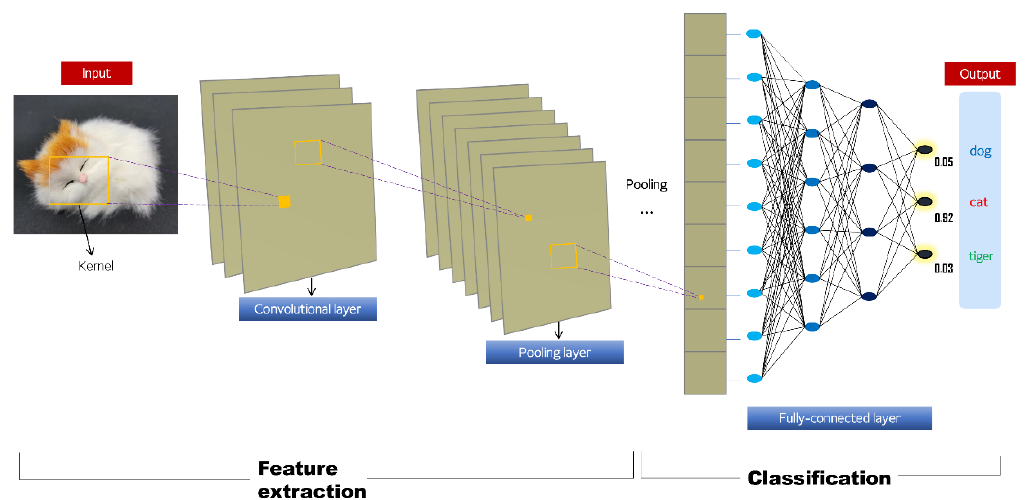
Figure 1. Schematic architecture of the convolutional neural network (CNN).